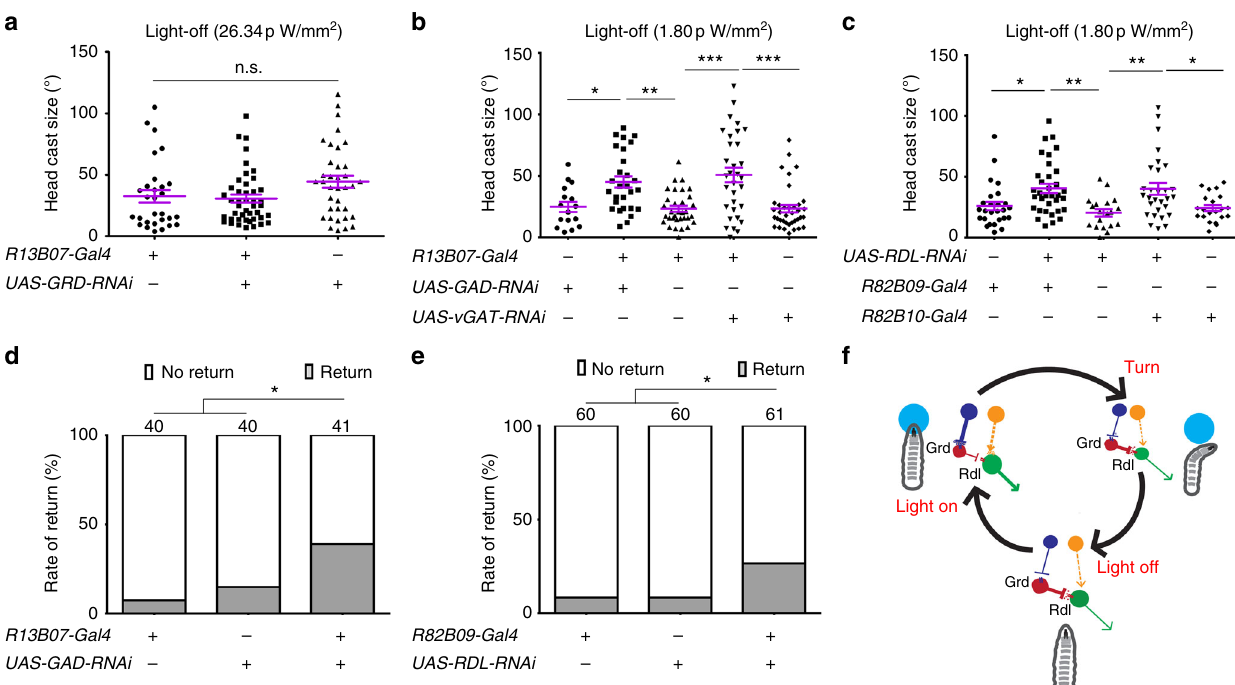
Fig. 5 Larval reorientation at light-off is repressed by reinhibition of CLPN R82B09 s. a – c Size of larval head cast at light-off in the light spot assay is unaffected by downregulation of GRD in LRIN R13B07 s ( a ), but is enhanced by down regulation of GAD/vGAT in LRIN R13B07 s ( b) or RDL in CLPN R82B09 s ( c) . d – e Knocking down GAD expression in LRIN R13B07 s ( d ) or RDL in CLPN R82B09 s ( e ) increases the rate of larva returning to light after light exit. Number above the columns indicates the sample sizes. f A cartoon showing the hypothesized working mechanism of the disinhibitory pathway in larval light avoidance. The large light blue circles indicate light spots. The circles with arrows are red for LRIN R13B07 , green for CLPN R82B09 , dark blue for clk-LexA labeled neurons and orange for unspeci fi ed excitatory neurons upstream of CLPN R82B09 s, respectively. Arrow heads indicate excitatory input. Bar heads indicate inhibitory input. The thickness of arrows indicates the strength of the inhibitory or excitatory effects. Light intensity in spot measured at 470 nm was 26.34 pW/mm 2 for a, 1.80 pW/mm 2 for b – e . n.s. not signi fi cant, * P < 0.05, ** P < 0.01, *** P < 0.001, one-way ANOVA with Tukey ’ s post hoc test in a – c , χ 2 -test with subgroup comparisons controlled by Benjamini-Hochberg method in d and e . Error bars, SEMs. Source data of a – e are provided as a source data fi the light/dark boundary and allowed to move freely for 10 min. Then the numbers of larvae in each half of agar plate were scored. Experimental temperature was at 25.5 °C. Larval light preference index (PI) was calculated as: PI = (number of larvae in the dark half – number of larvae in the light half)/ (number of larvae in the dark half + number of larvae in the light half). PIs were shown as mean± SEM.